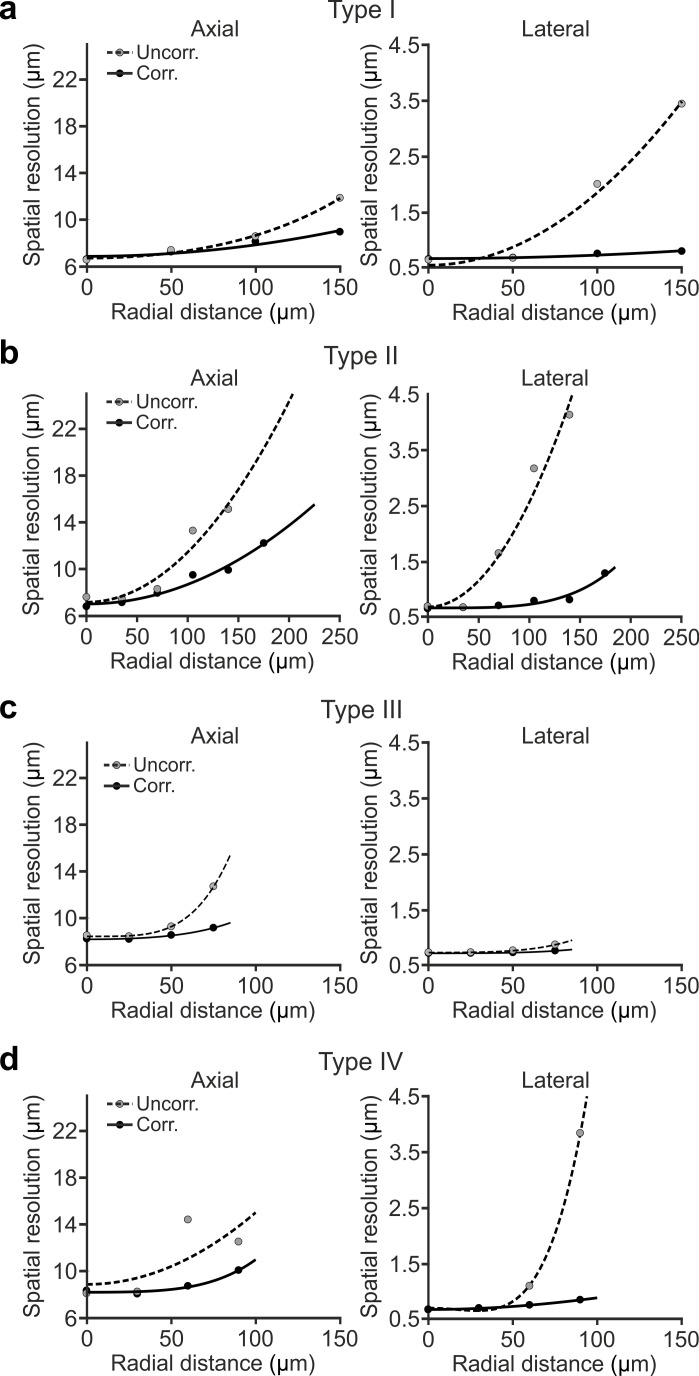
Simulated spatial resolution is improved in eFOV-microendoscopes.(a) Simulated axial (left) and lateral (right) spatial resolution (see Materials and methods for definition) as a function of the radial distance from the center of the FOV for type I uncorrected (dashed line) and corrected (solid line) microendoscopes. Points represent simulated values, lines are quartic functions fitting the data. (b) Same as in (a) for type II microendoscopes. (c) Same as in (a) for type III microendoscopes. (d) Same as in (a) for type IV microendoscopes.Figure 2—figure supplement 2—source data 1.Simulated values of the axial and lateral spatial resolution as a function of radial distance from the center of the FOV in uncorrected and corrected microendoscopes.